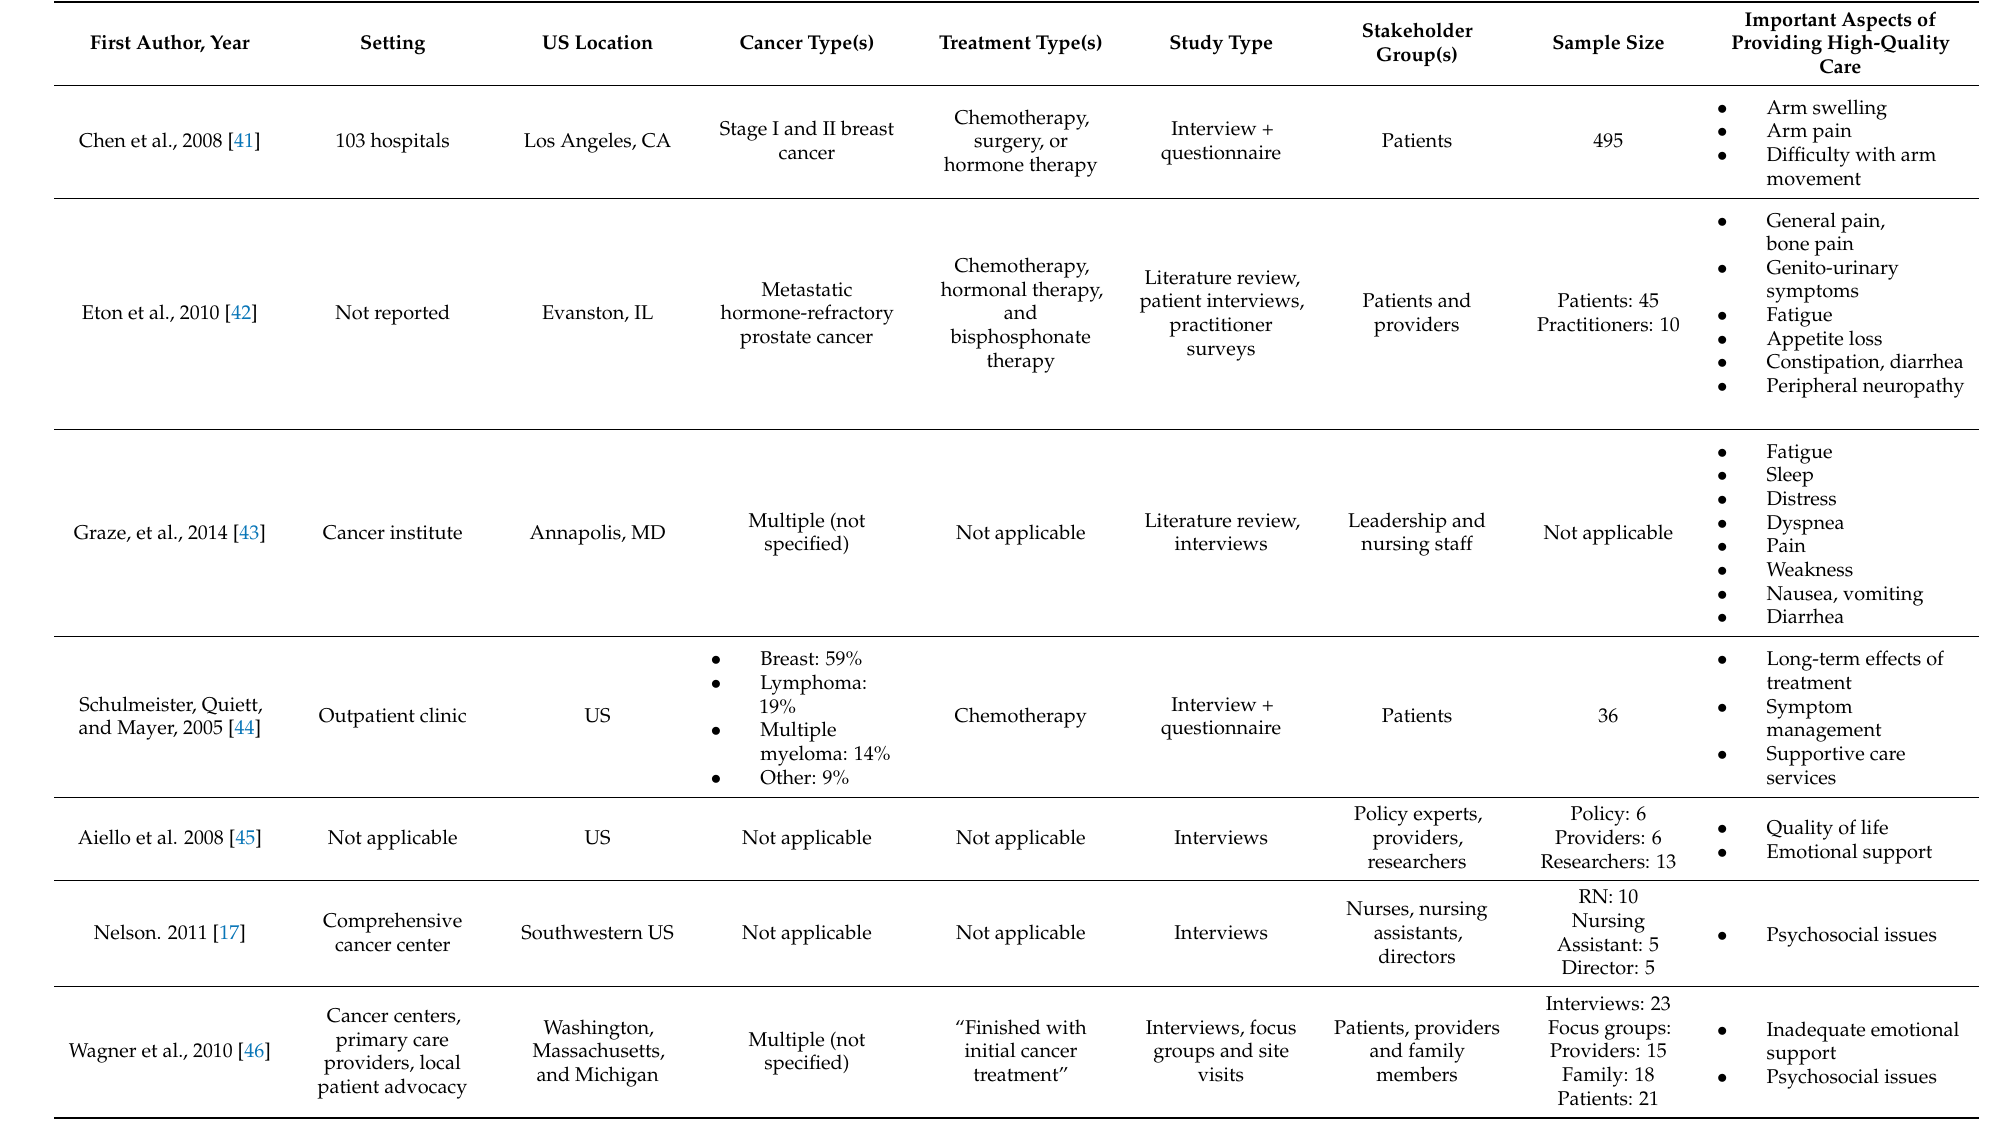
Table 3. Studies conducted in the US ( n =